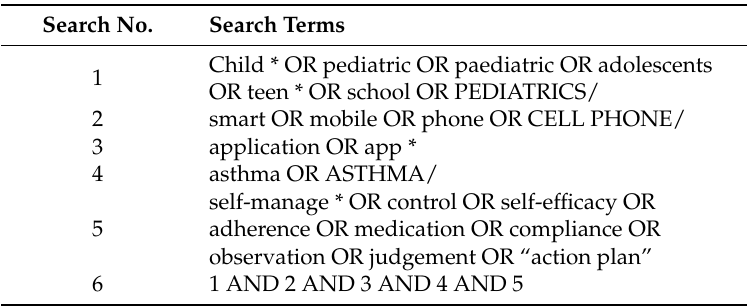
Table 1. Ovid search